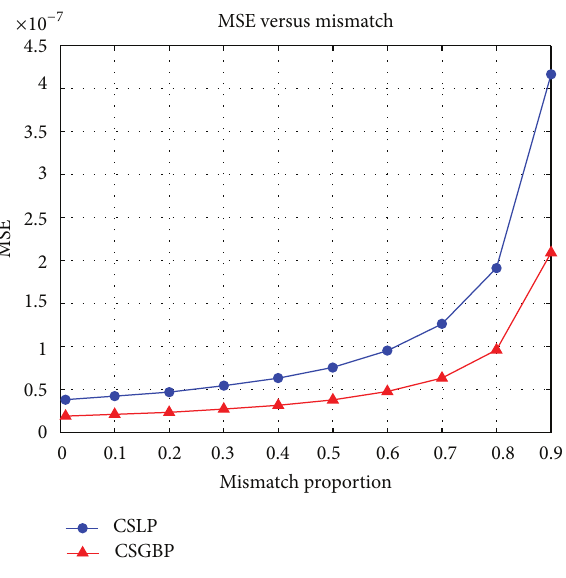
Figure 1: MSE using CSLP and